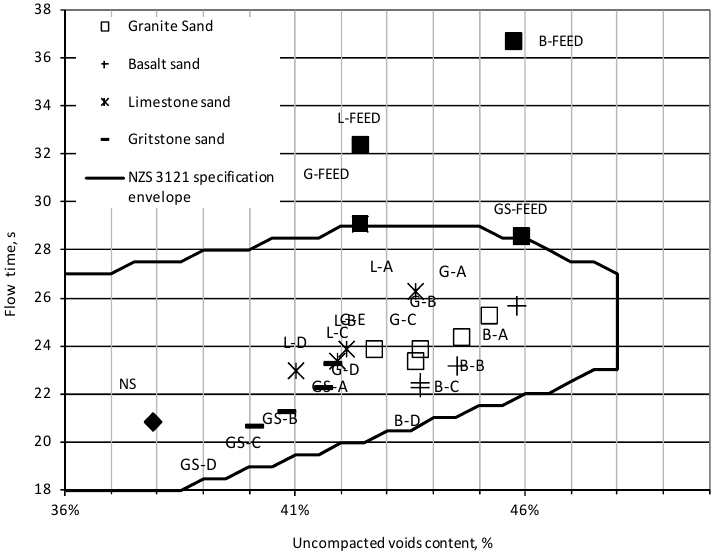
Figure 3. New Zealand flow cone results.